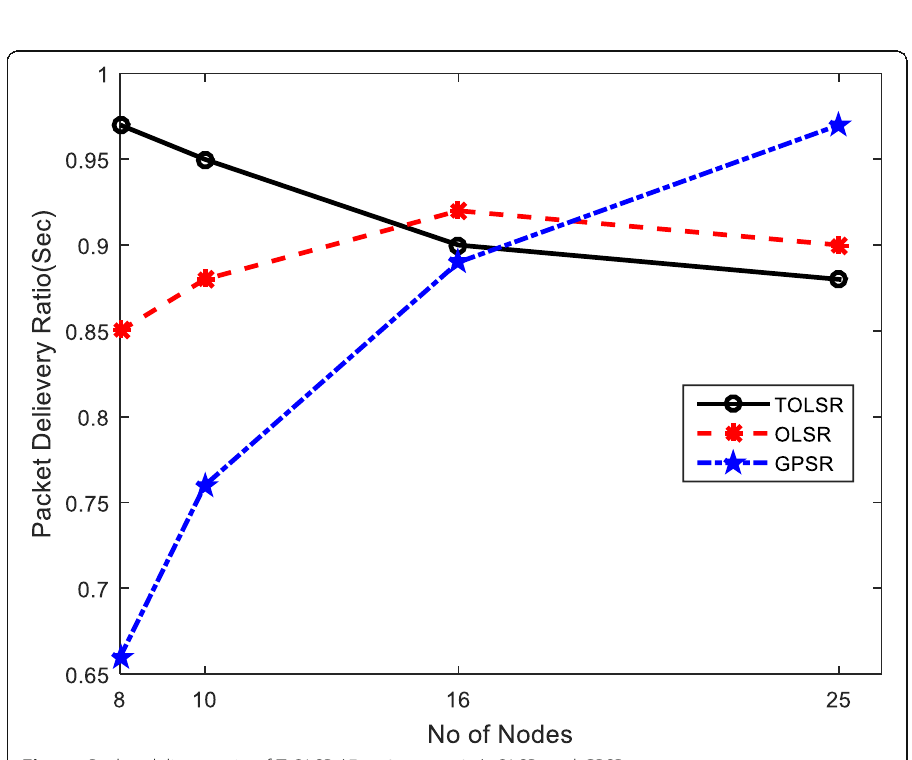
Fig. 14 Packet delivery ratio of T-OLSR ( Ф = 2 s, τ = 10 s), OLSR, and